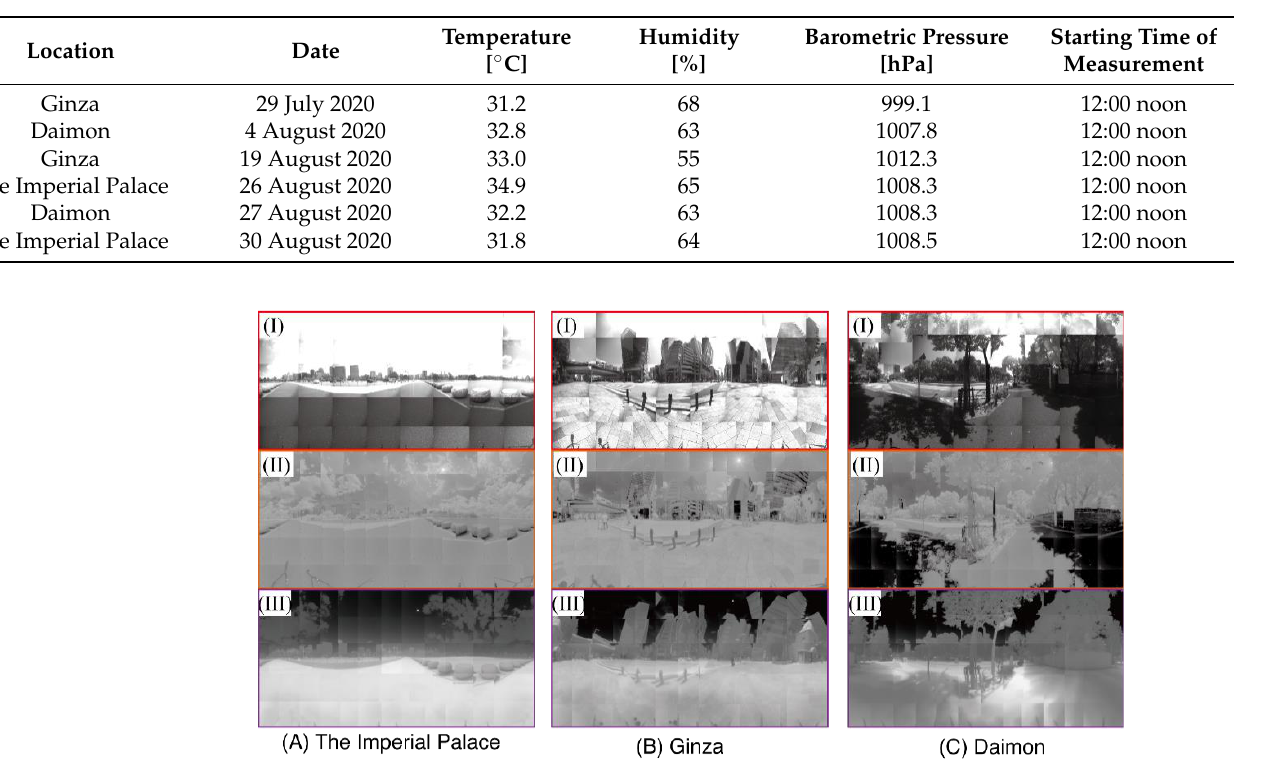
Figure 7. Panoramic images in the measurement locations: ( A ) the Imperial Place, ( B ) Ginza, and ( C ) Daimon. Table 1. Environmental conditions of measurement location in summer experiments.